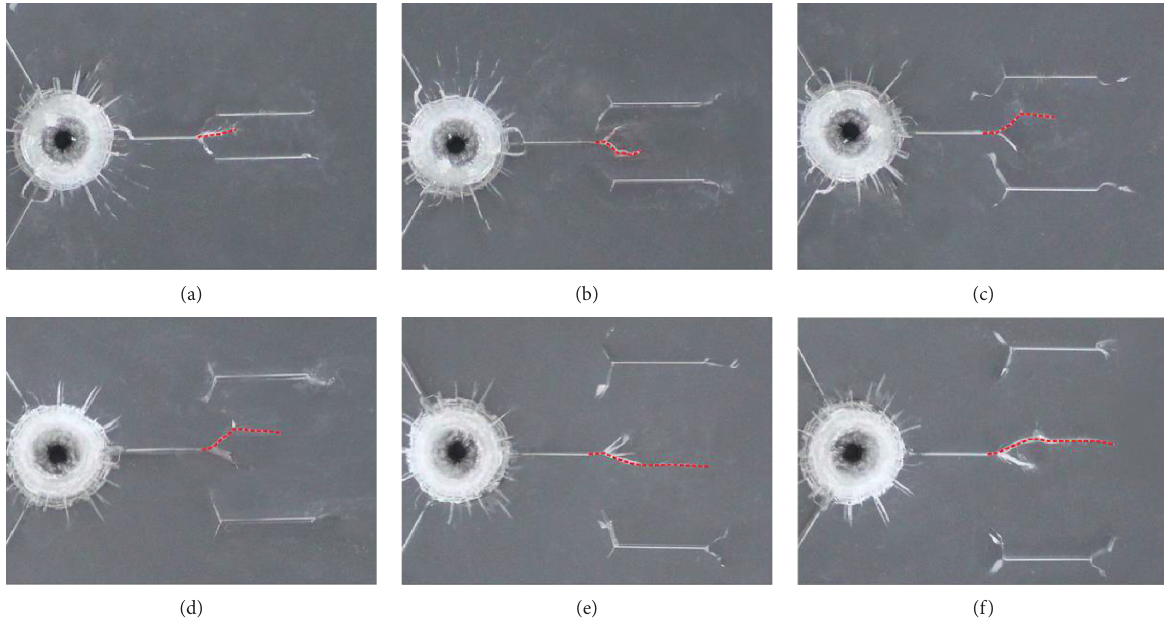
Figure 7: Crack propagation patterns under parallel symmetrical cracks in PMMA specimens. (a) S � 20mm. (b) S � 35mm. (c) S �